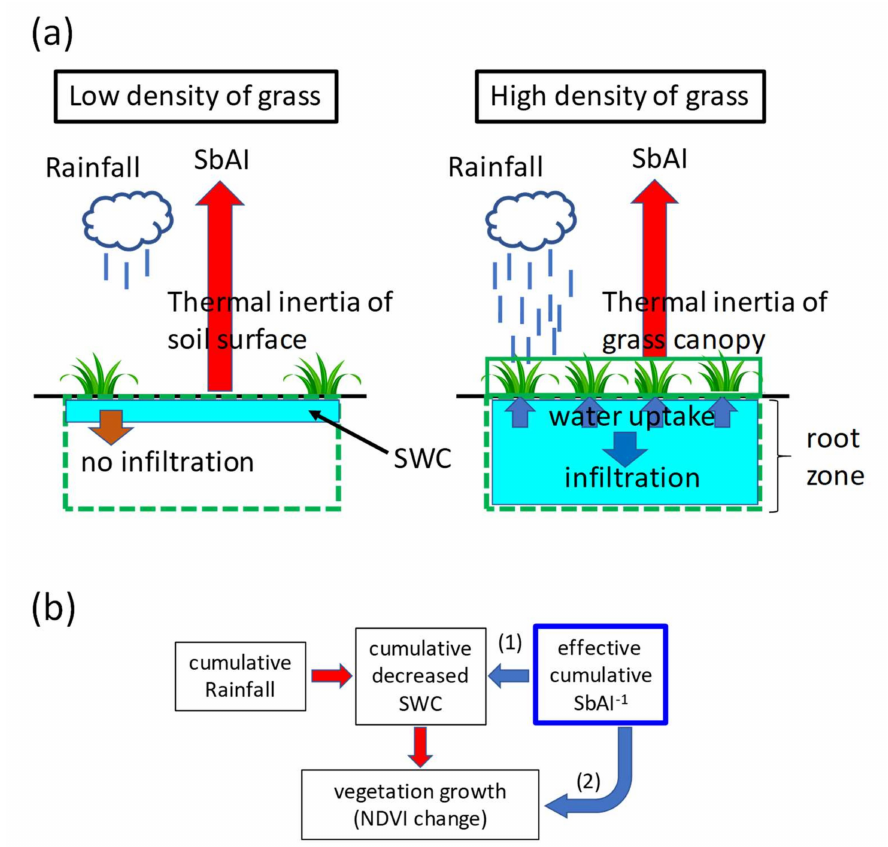
Figure 2. Concepts of this study. ( a ) Relationships among the vegetation density, soil water content (SWC), and satellite-based aridity index (SbAI). Red upward arrow, thermal inertia; green dashed box, root zone; green solid box, grass canopy. ( b ) Relationships among the cumulative rainfall, cumulative decreased SWC (CdSWC), e ff ective cumulative 1 / SbAI (CRSbAI), and vegetation growth ( ∆ NDVI ). Red arrows, relationship among cumulative rainfall, CdSWC, and vegetation growth; blue arrows, research concept: (1) Can the CRSbAI replace CdSWC? (2) Is the CRSbAI related to vegetation